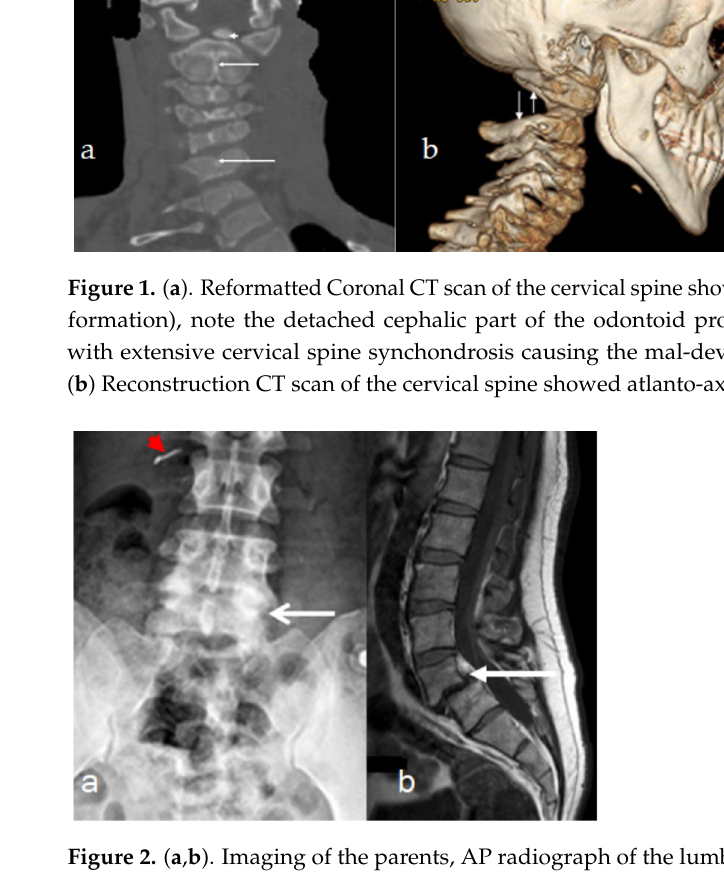
(Figure 2b). Phenotype/genotype of the family with spondylo-meg-epiphyseal-dysplasia appears in Table 1.